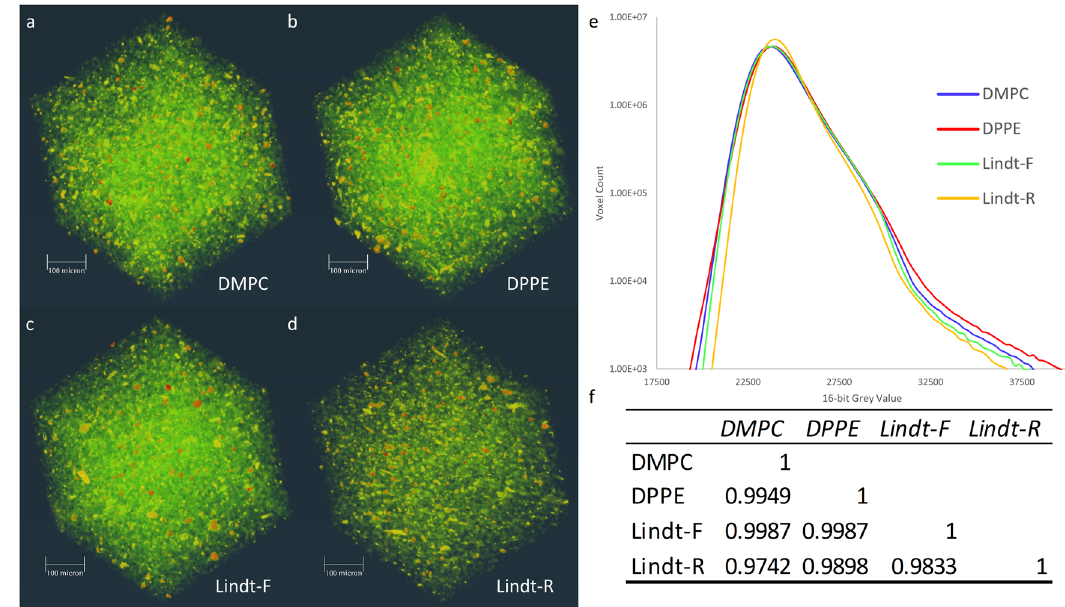
Fig. 6 Volume renderings of reconstructed slices, plotted histograms, and correlation matrix of SR- µ CT data. Samples included a molten and recrystallized commercial chocolate with added 0.1% (w/w) dimyristoylphosphatidylcholine (DMPC), Supplementary Movie 1; b molten and recrystallized commercial chocolate with added 0.1% (w/w) dipalmitoylphosphatidylethanolamine (DPPE), Supplementary Movie 2; c fresh commercial chocolate (Lindt-F), Supplementary Movie 3; d molten and recrystallized commercial chocolate (Lindt-R), Supplementary Movie 4; e plotted histograms, and f correlation